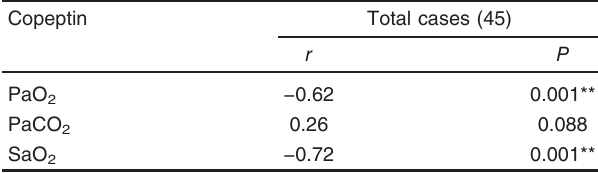
Table 9 Comparison of copeptin level between male and female in all groups Table 10 Correlation between copeptin and partial pressure of oxygen in arterial blood, partial pressure of carbon dioxide in arterial blood, and oxygen saturation